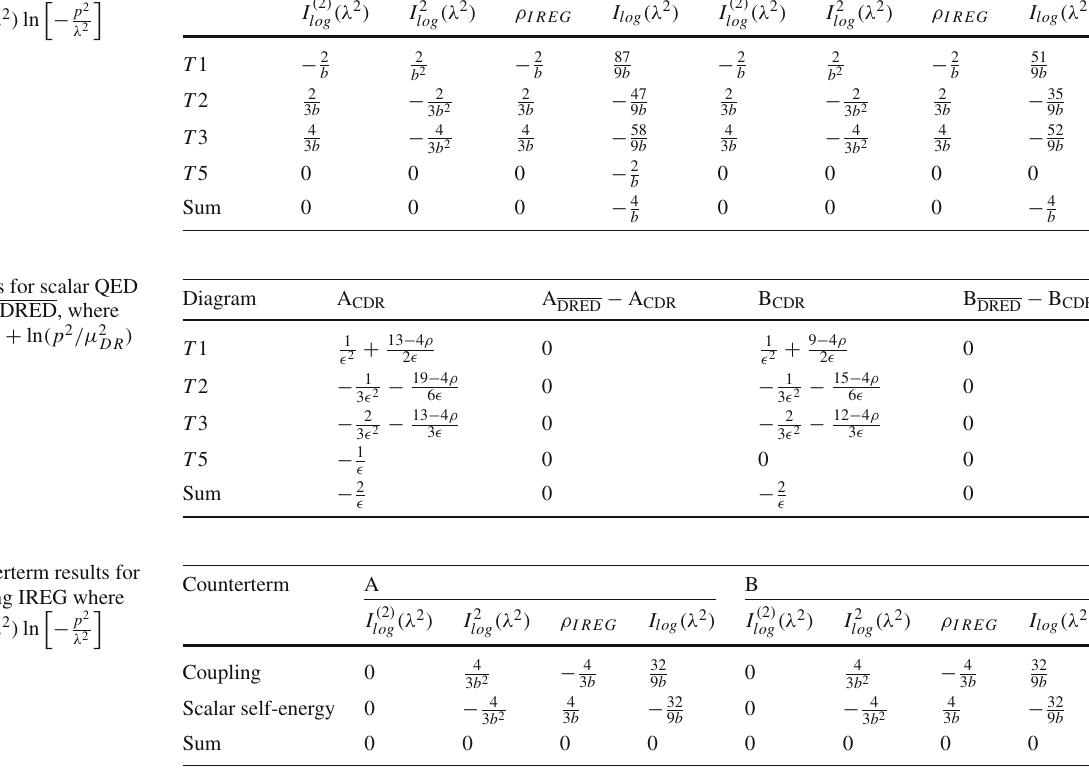
Table 2 Results for scalar QED using IREG where ρ = I (λ 2 ) ln IREG log